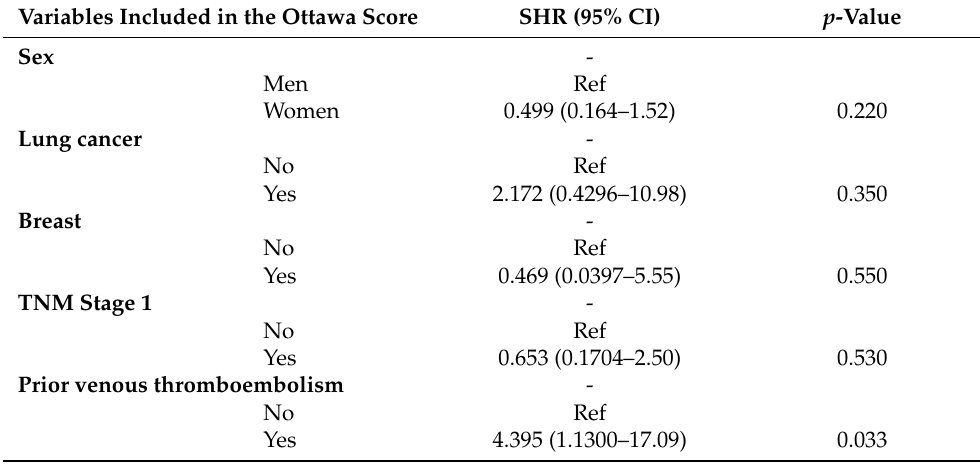
Table 2. Multivariable analyses for recurrent VTE during the 6 ‐ month follow ‐ up.